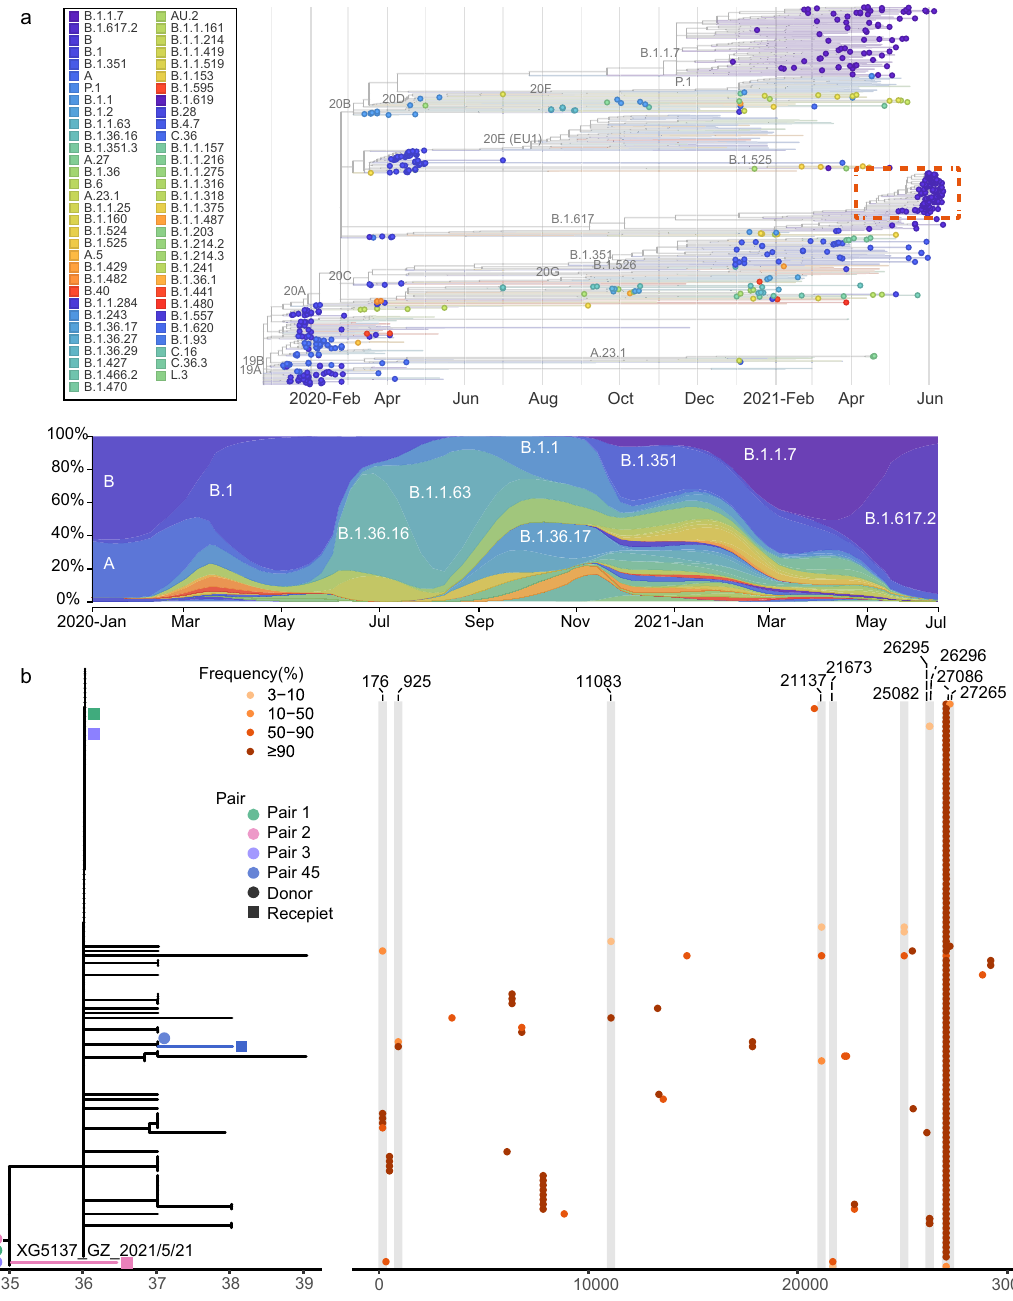
Fig. 2 Viral phylogenies and transmission dynamics of the Guangzhou outbreak. a A time-resolved phylogenetic tree was estimated using the NextStrain pipeline and includes (i) Guangdong sequences collected from local infections and imported cases, January 2020 – June 2021, and (ii) reference sequences from different genetic lineages. The sequences from the Guangdong Delta variant outbreak (21 May 2021 – 18 June 2021) are highlighted with a red box. The changing frequencies of SARS-CoV-2 lineages (according to pangolin classi fi cation scheme, https://github.com/cov-lineages/pangolin) identi fi ed in Guangdong (most of which are imported) are shown in the lower panel. b Maximum likelihood tree of 126 sampled sequences of the Guangzhou outbreak. The sequence of the fi rst index case (XG5137_GZ_2021/5/21) was used as the reference. SNV frequencies (%) across the virus genome (numbering according to the reference) are marked with colored dots (right hand